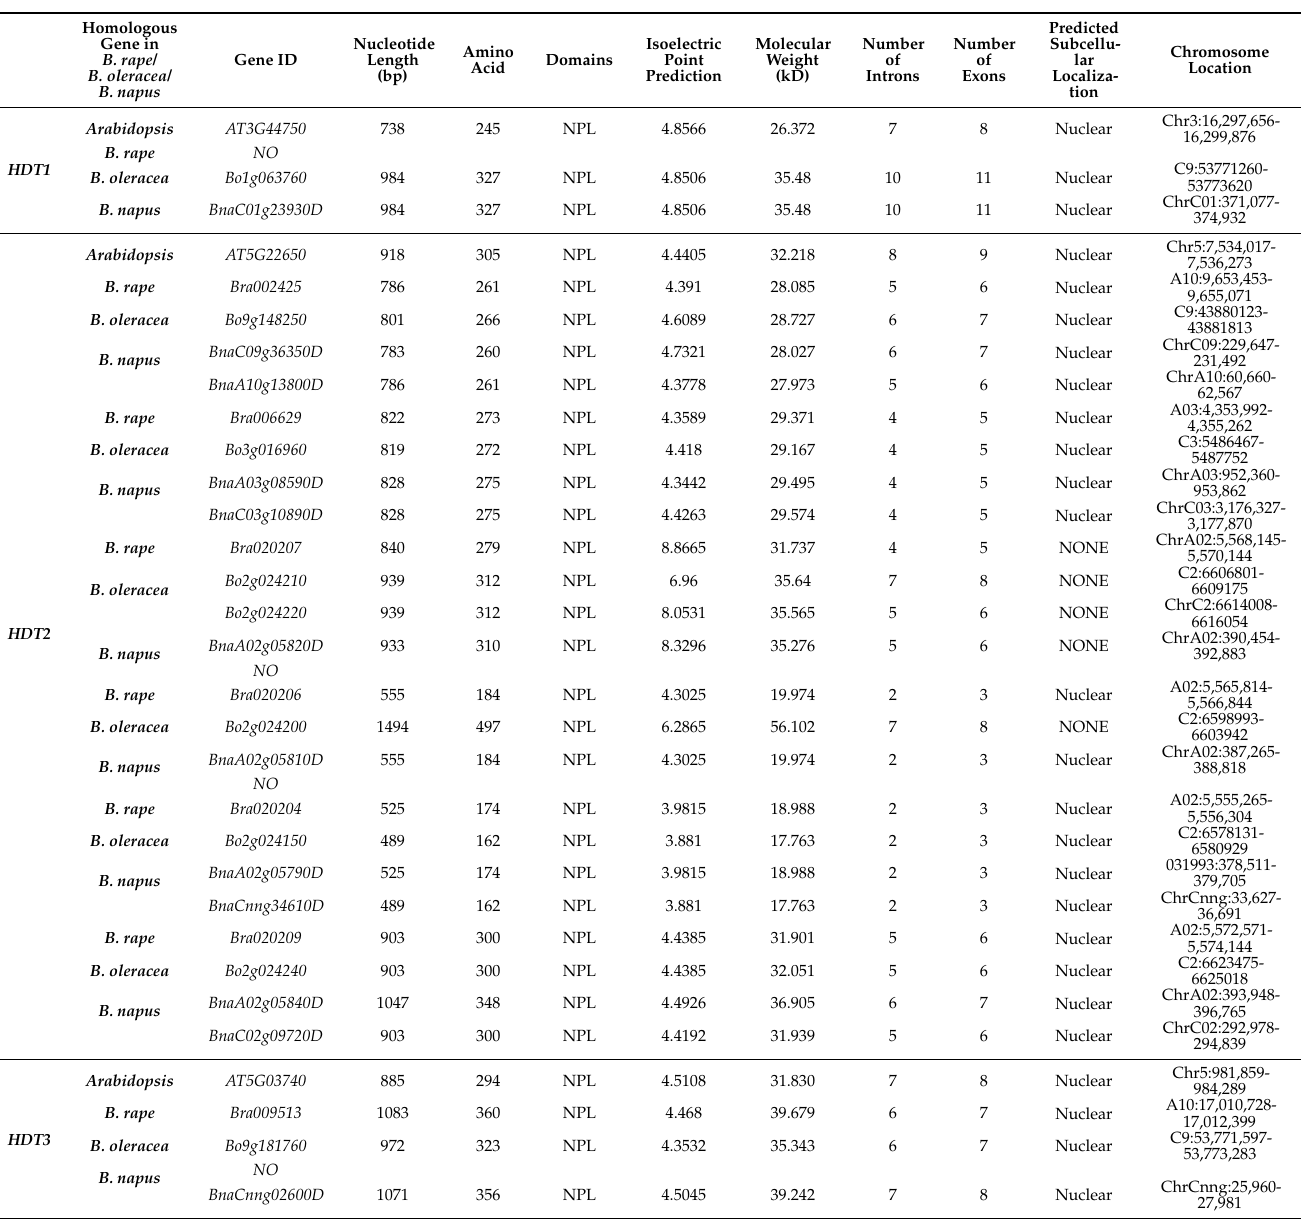
Table 1. List of HDT genes identified in Arabidopsis , B. rape , B. oleracea and B. napus . Homologous Gene in B.